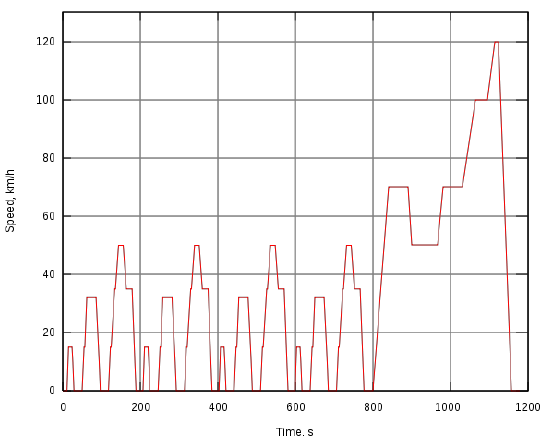
Figure 8. The New European Driving Cycle (NEDC): A driving cycle designed to assess the emission levels of car engines. It is also referred to as MVEG cycle (Motor Vehicle Emissions